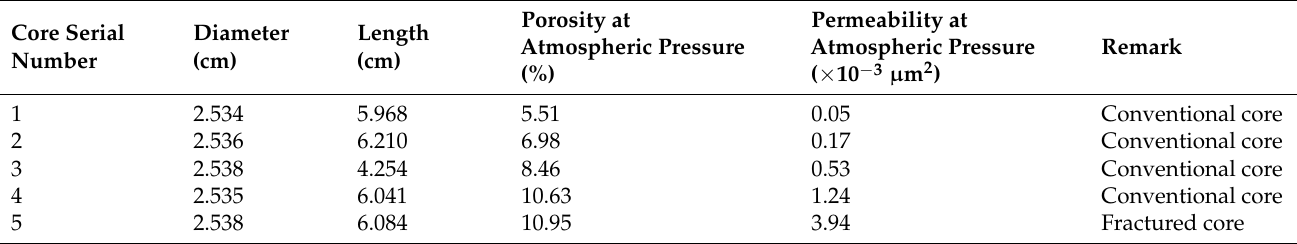
Table 1. Test core physical